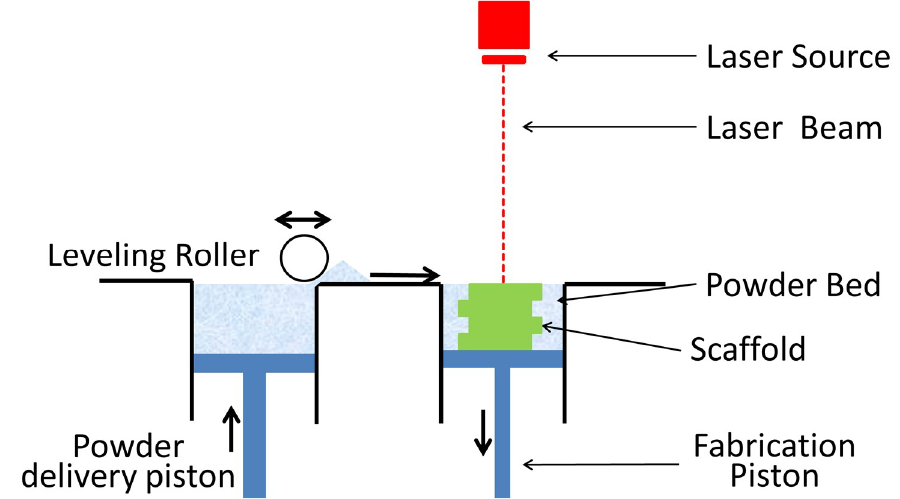
Figure 4. Schematic of selective laser sintering (SLS) process. A laser source sinters/melts the top layer of powder in a powder bed in a predetermined pattern. The powder bed is lowered in height and a fresh layer of powder is positioned on top via a leveling roller. The process is then repeated.